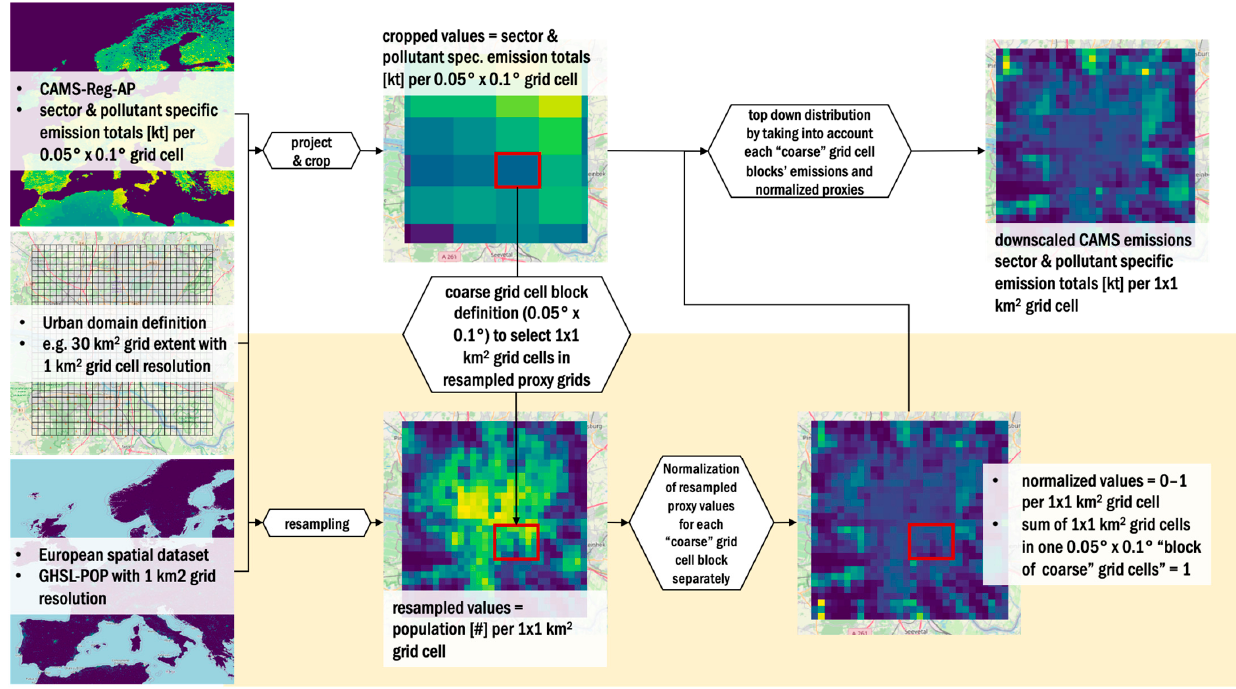
Figure 3. Area emissions downscaling procedure to the urban-scale based on an urban domain definition ( top ) and preparation of spatial proxies for downscaling ( bottom ) under consideration of spatial distribution in the “coarse” resolution CAMS-REG (or any other) dataset.